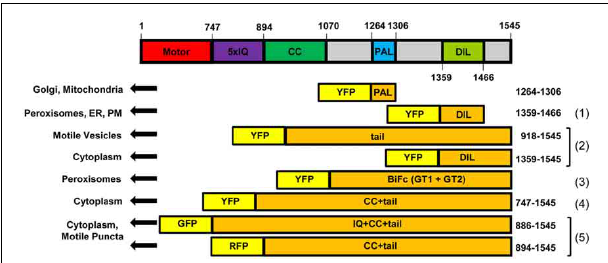
FIGURE 9 | Diagram of At XI-K constructs that have been expressed in Nicotiana. Constructs diagramed are (1) from Sattarzadeh et al. (2011), (2) from Reisen and Hanson (2007), (3) from Li and Nebenfuhr (2007), (4) from Sparkes et al. (2008), and (5) from Avisar et al. (2009). CC: coiled-coil. IQ: IQ repeats. BiFC: construct for Bimolecular Fluorescence Complementation. PM: Plasma